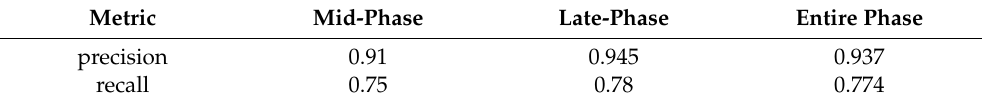
Table 5. Performance of increased data amount for online safety classifier.